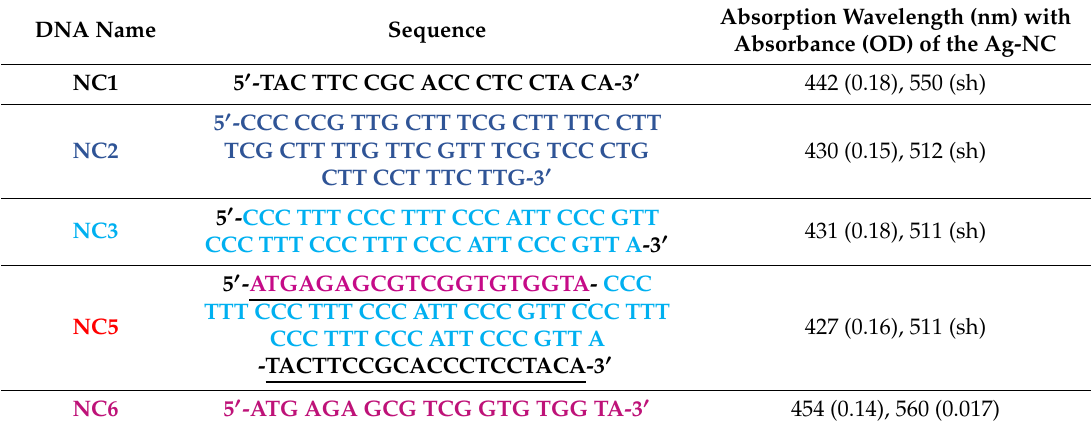
Table 2. Sequences of the single stranded DNA oligonucleotides used for synthesizing the silver nanoclusters (Ag-NC). The absorption wavelengths along with absorbance of the silver nanoclusters are provided in the third column. The left and right conserved primer sequences are underlined. The color designations are used to distinguish the sequences and are consistent in Figures 1, 2 and